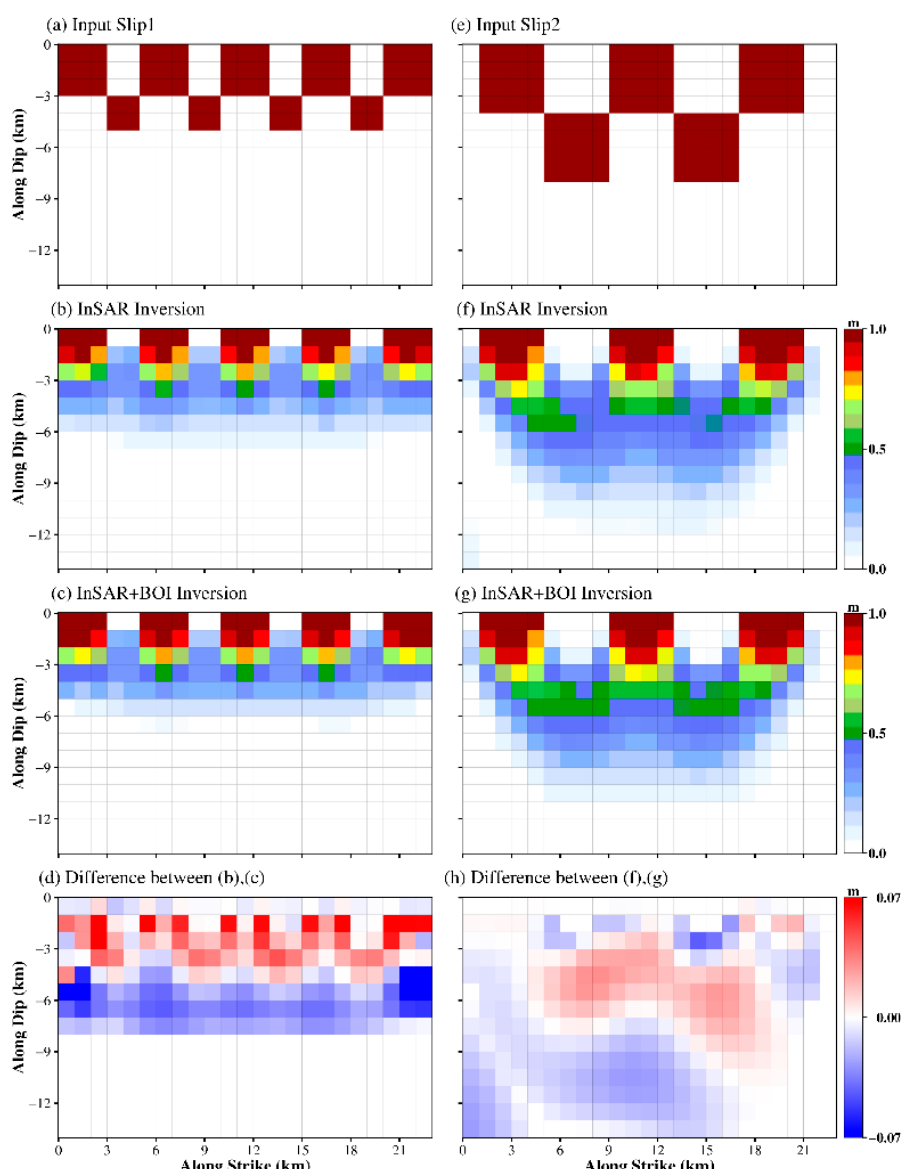
Figure 10. Model resolution for the checkerboard test. ( a ) Input slip model 1 and ( e ) input slip model 2 for calculating the synthetic displacements of InSAR data. ( b ) and ( f ) used InSAR LOS displacements. ( c ) and ( g ) combined InSAR LOS displacements and BOI azimuth displacements. ( d ) and ( h ) Difference between ( c ) and ( b ), ( g ) and ( f ), respectively.